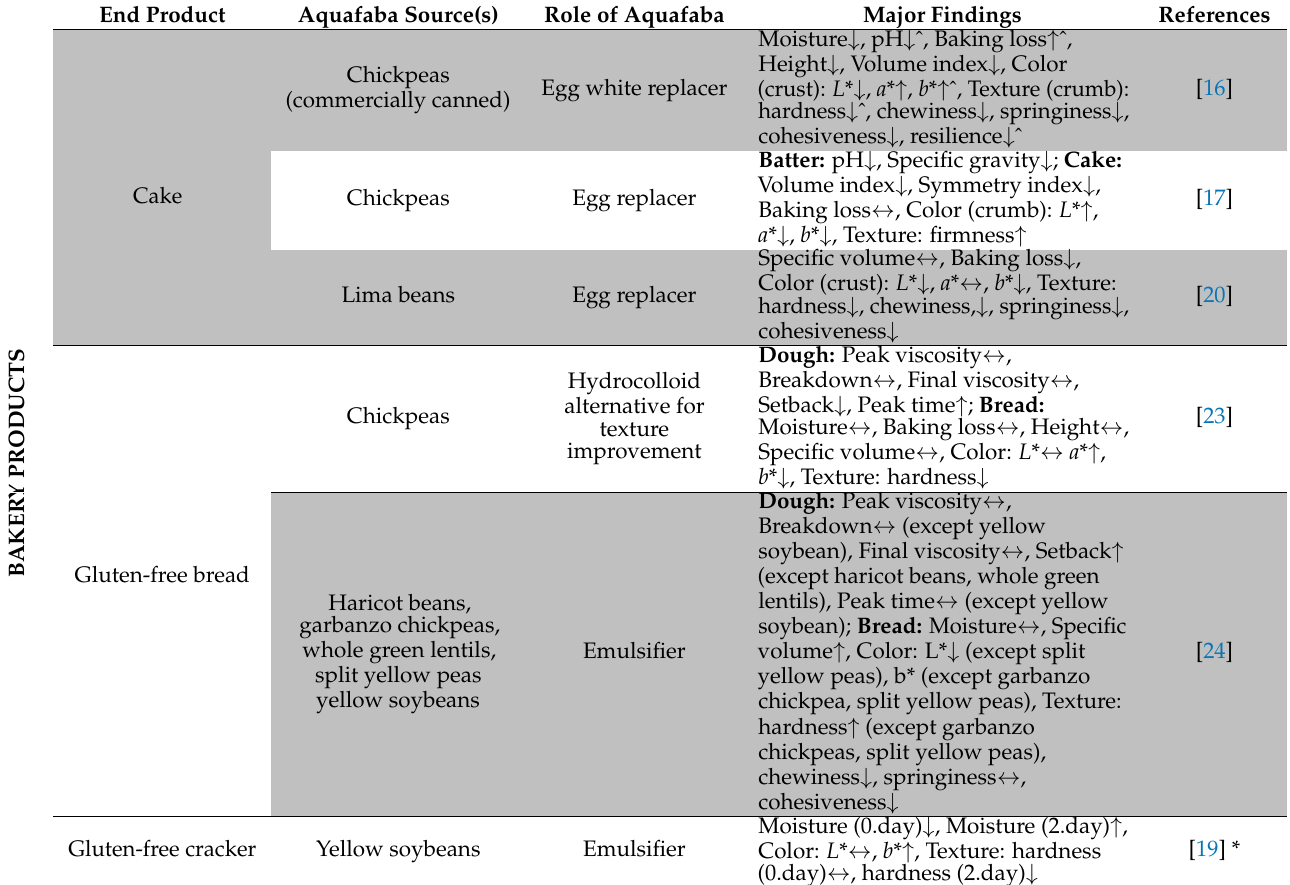
Table 1. Aquafaba sources, their role, and major findings regarding aquafaba-based food